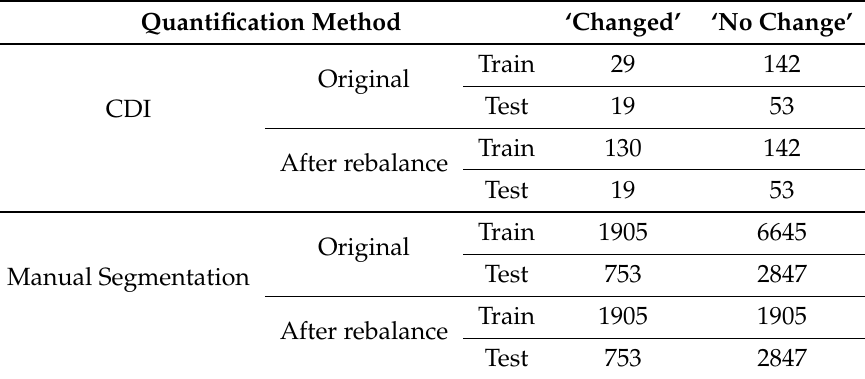
Table 5. Sample distribution in experiment